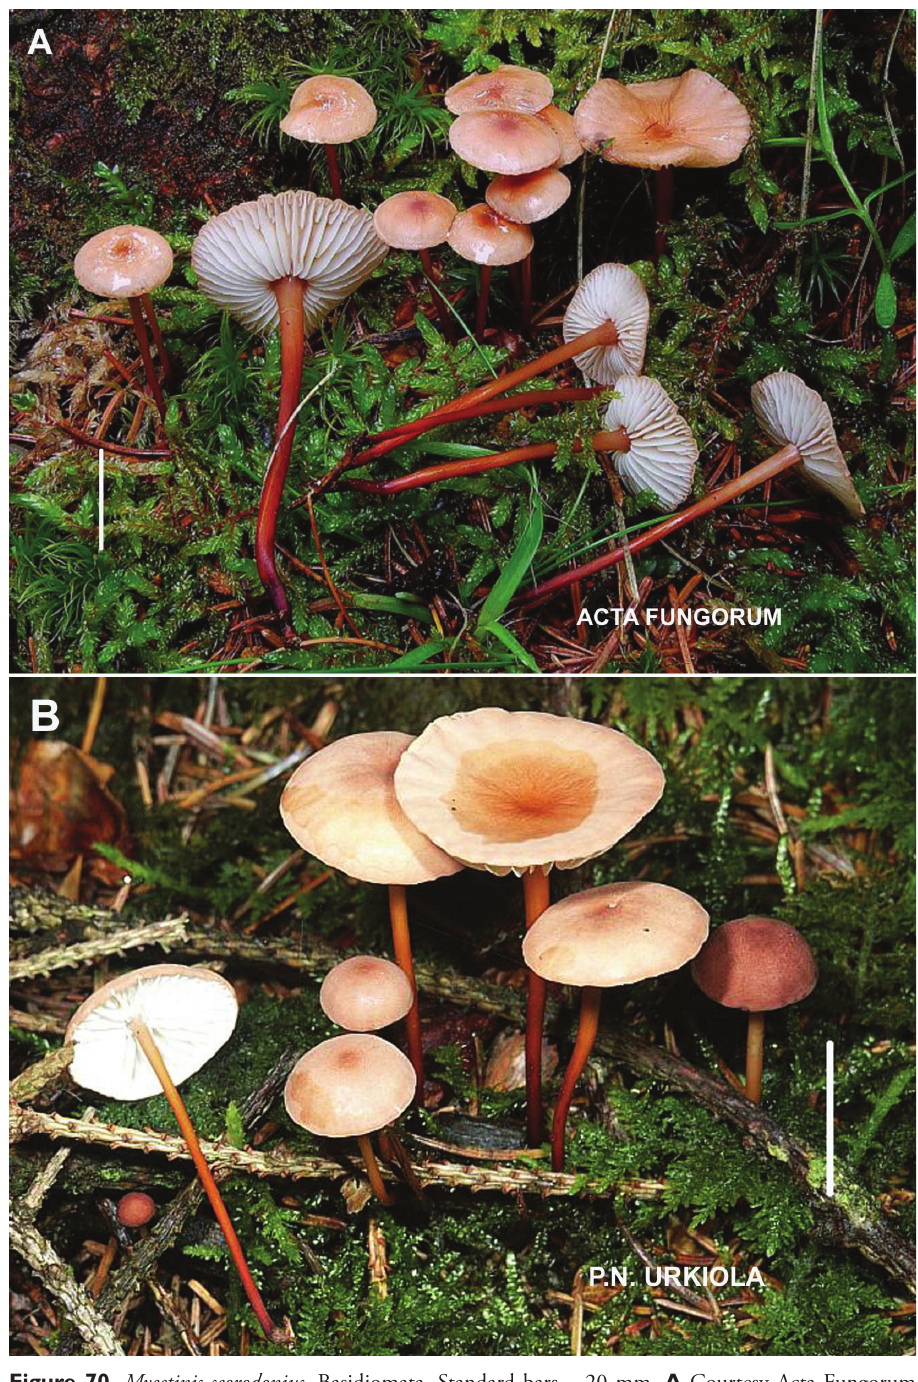
Figure 70. Mycetinis scorodonius . Basidiomata. Standard bars = 20 mm. A Courtesy Acta Fungorum B Courtesy P.N.